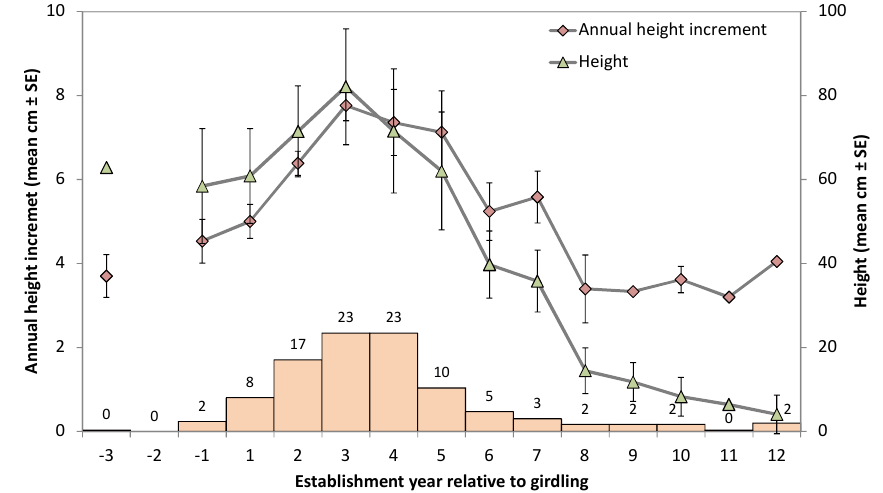
Figure 1. Pine seedling establishments under girdled pine trees in relation to the time of girdling (bars, % of total seedlings) and the seedlings’ mean annual height increment during their lifetime ( ◊ ) and present height ( ∆ ). Values represent the current means of the seedlings established that particular year. Values above bars indicate the proportion (%) of total